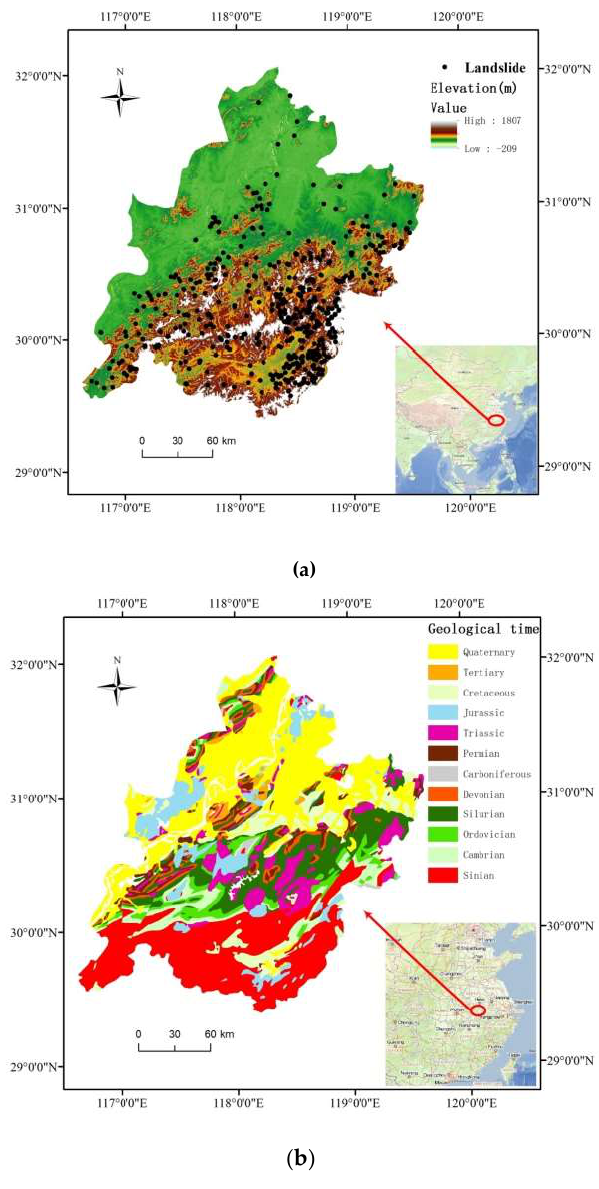
Figure 2. Distribution of landslide sites in southern Anhui, China: ( a ) elevation map based on a 30 m digital elevation model (DEM) from shuttle radar topography mission (STRM), ( b ) geologic map of the